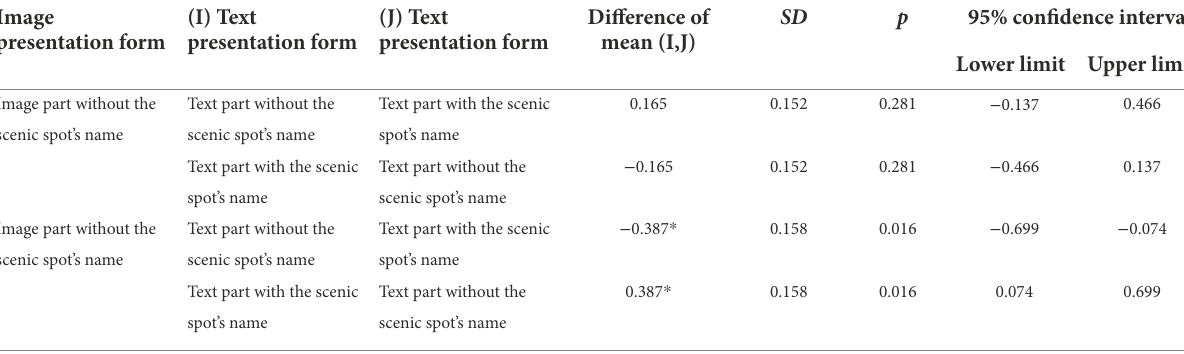
TABLE 6 Pairwise comparison of Image presentation form × text presentation form.